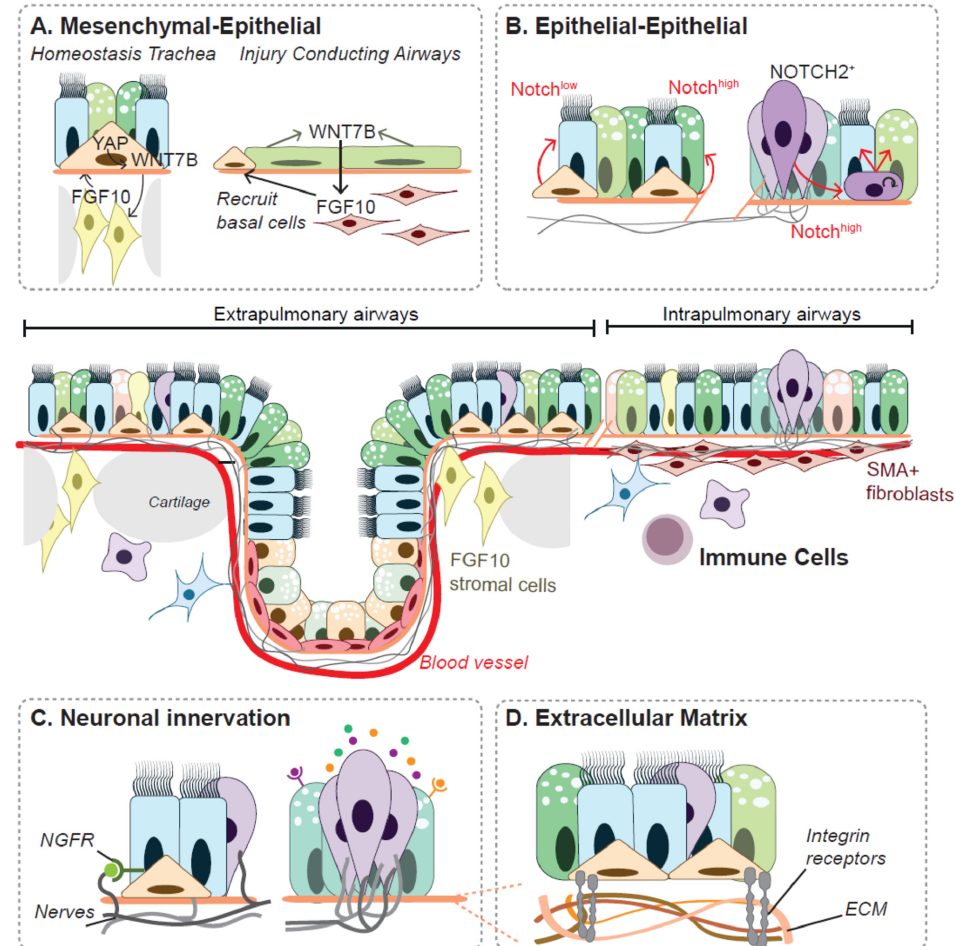
Figure 1. Extrinsic signaling cues coordinate lineage decisions of progenitor cells. Around SOX2+SOX21+ airway epithelium, trachea, submucosal glands and neuroendocrine cells, different cellular (mesenchymal-, epithelial-, neuronal- and immune- cells) and non-cellular components (extracellular matrix) contribute to the behavior of progenitor cells. ( A ) HIPPO-WNT-FGF reciprocal signaling between basal and underlying stromal cells, contribute to the maintenance of basal cells in the tracheal epithelium. Upon injury, damaged epithelium secrete WNT7B and FGF10 is secreted from Smooth muscle actin positive (SMA+) fibroblasts, which recruit basal cells to regenerate the epithelium. ( B ) Notch signaling guides differentiation of basal cells to secretory (Notch high ) or ciliated (Notch low ) cells. A subset of neuroendocrine (NE) cells in a NE cluster in Notch2 + , and is suggested to function as stem cell. Upon injury, the NE dedifferentiate to a transit amplifying cells under control of high Notch signaling. This transit amplifying cell subsequently differentiates to ciliated or secretory cells, probably also through receiving high or low notch signal [37]. ( C ) The tracheal epithelium and neuroendocrine cells are innervated by neurons. Stimulation of PNECs can lead to the secretion of factors that might act on corresponding receptors present on the airway epithelium or can increase immune infiltrates [38–40]. Basal cells contain the P75-neuronal growth factor receptor (NGFR), which, potentially is stimulated by secretion of NGF by neuronal cells. However, this pathways has not yet been studied in the airway epithelium ( D ) Extracellular matrix (ECM) proteins are underlying the airway epithelial cells. Airway epithelial cells interact with ECM protein through integrin receptors, upon damage these interactions might change which can influence progenitor cell behavior.